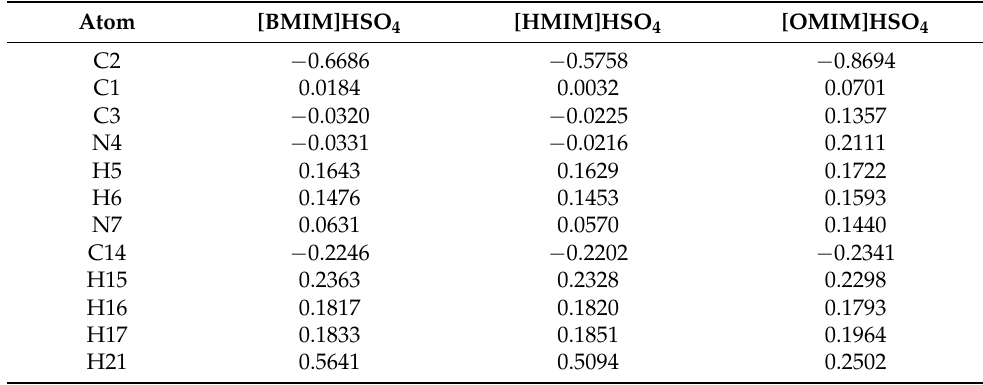
Table 6. Mulliken charges of atoms in the imidazolium